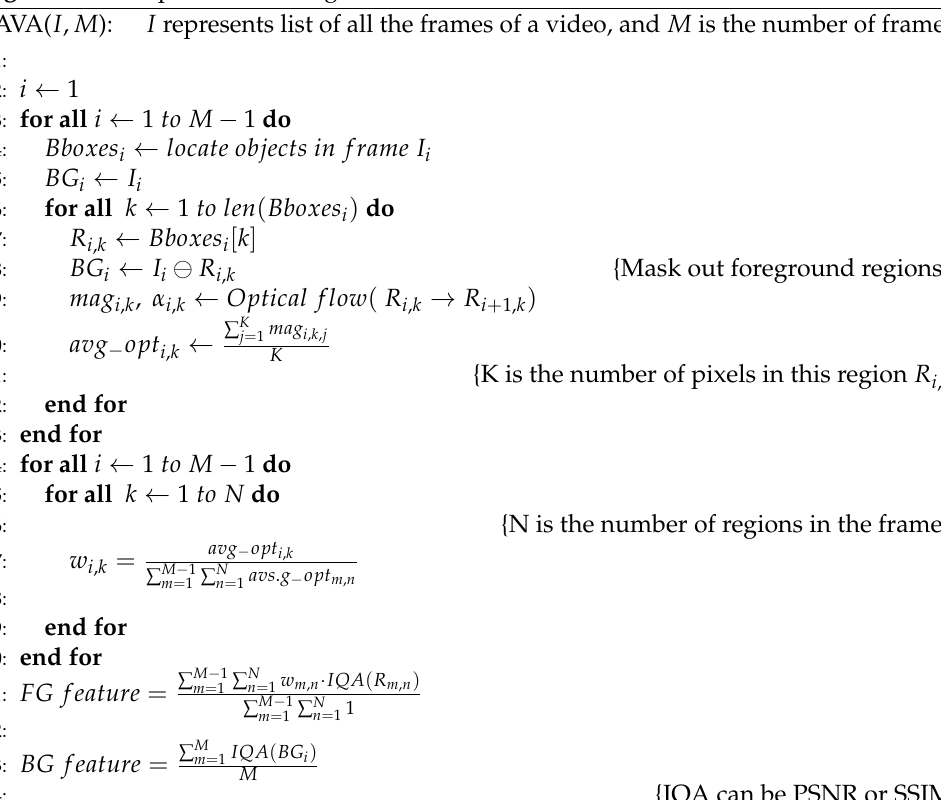
Algorithm 1 Proposed RAVA